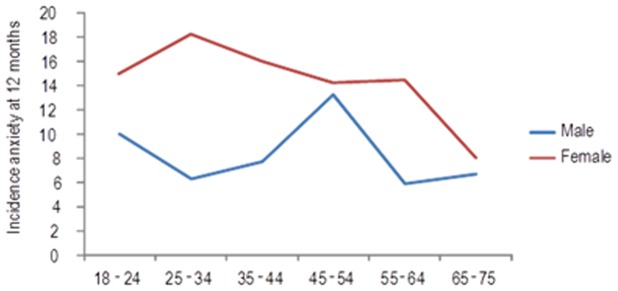
Incidence of anxiety by age and sex.